Question: Identify the chart type used in this figure.
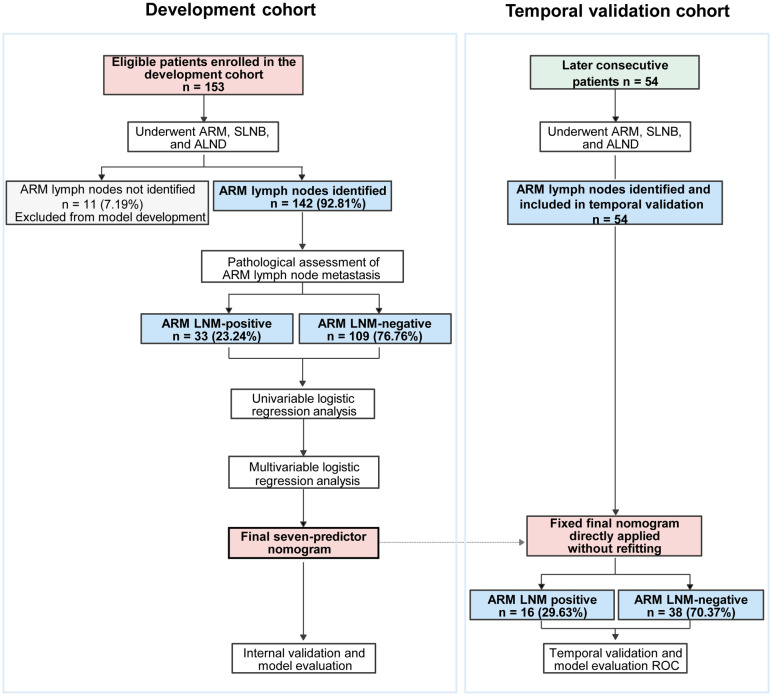
Answer: line